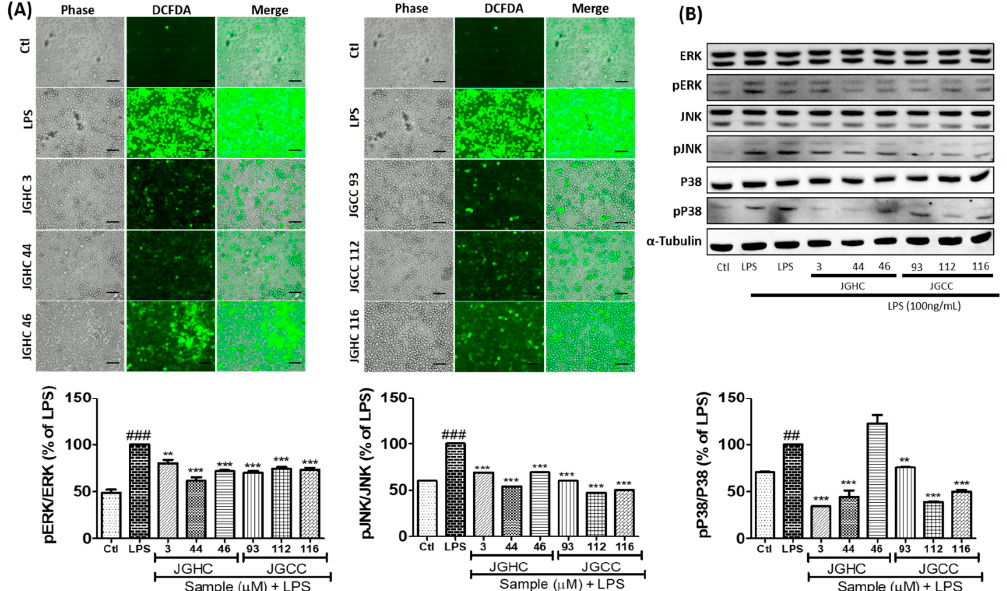
Figure 5. Active components from A. holophylla subfractions inhibited ROS production and MAPK expression. BV2 cells were pre-treated with 5 µM of JHC 3, JGHCC 44, JGHC 46, JGCC 93, JGCC 112, and JGCC 116, and activated with LPS (100 ng/mL) for 30 min; cells were incubated with DCFDA for measuring ROS production. Treated cells were harvested and protein expression was observed using Western blot analysis. ( A ) ROS production. Scale bars = 50 µm. ( B ) Western blot analysis and quantification of MAPK signaling proteins. Tubulin was used as a loading control. ** p < 0.01 and *** p < 0.001 indicate significant differences compared with treatment of LPS alone, while ## p < 0.01 and ### p < 0.001 indicate significant differences compared with the untreated control group. Ctl indicates untreated control cells, LPS indicates LPS- treated cells.